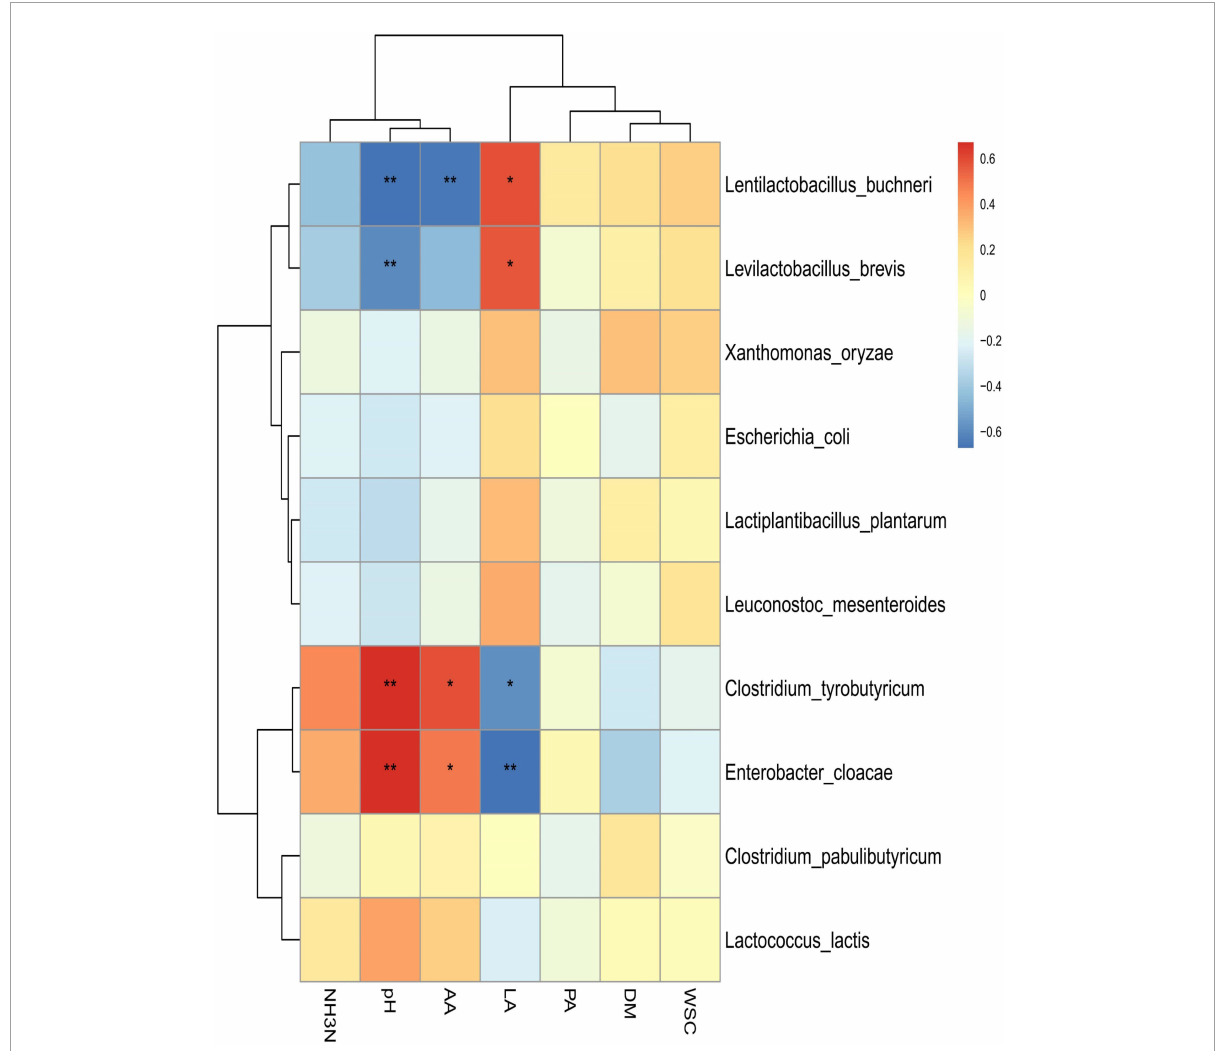
FIGURE4 Spearman correlation heatmap of abundance of microbial community and fermentation properties in high-moisture amaranth silage with Lactobacillus plantarum and propionic acid additives. AhGCK, control; AhGLP, L. plantarum ; AhGPA, propionic acid; AA, acetic acid; DM, dry matter; LA, lactic acid; PA, propionic acid; WSC, water soluble carbohydrate. * p < 0.05; ** p < 0.01.